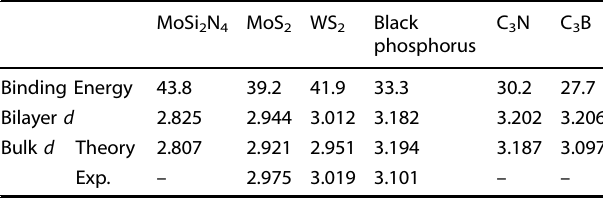
Table 1. Comparison between the calculated interlayer binding energy (E bind = (2E monolayer − E bilayer )/A, in meV/Å 2 ) and interlayer separation d (in Å) of MoSi 2 N 4 with a few selected layered materials using the PBE functional with the DFT-D3